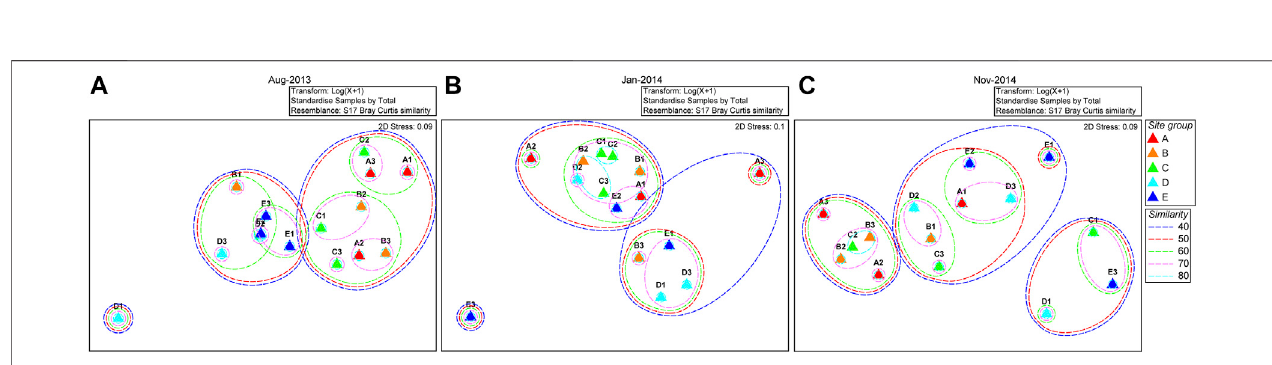
FIGURE7| Themulti-scalinganalysisbiplotsformonitoringsitesinGonghuBaybasedontheBray-Curtissimilaritymatrices ofphytoplankton communitiesduring the six sampling periods from 2013 to 2014. The classi fi cation of monitoring sites was based on three levels (40, 50, 60, 70, and 80%).